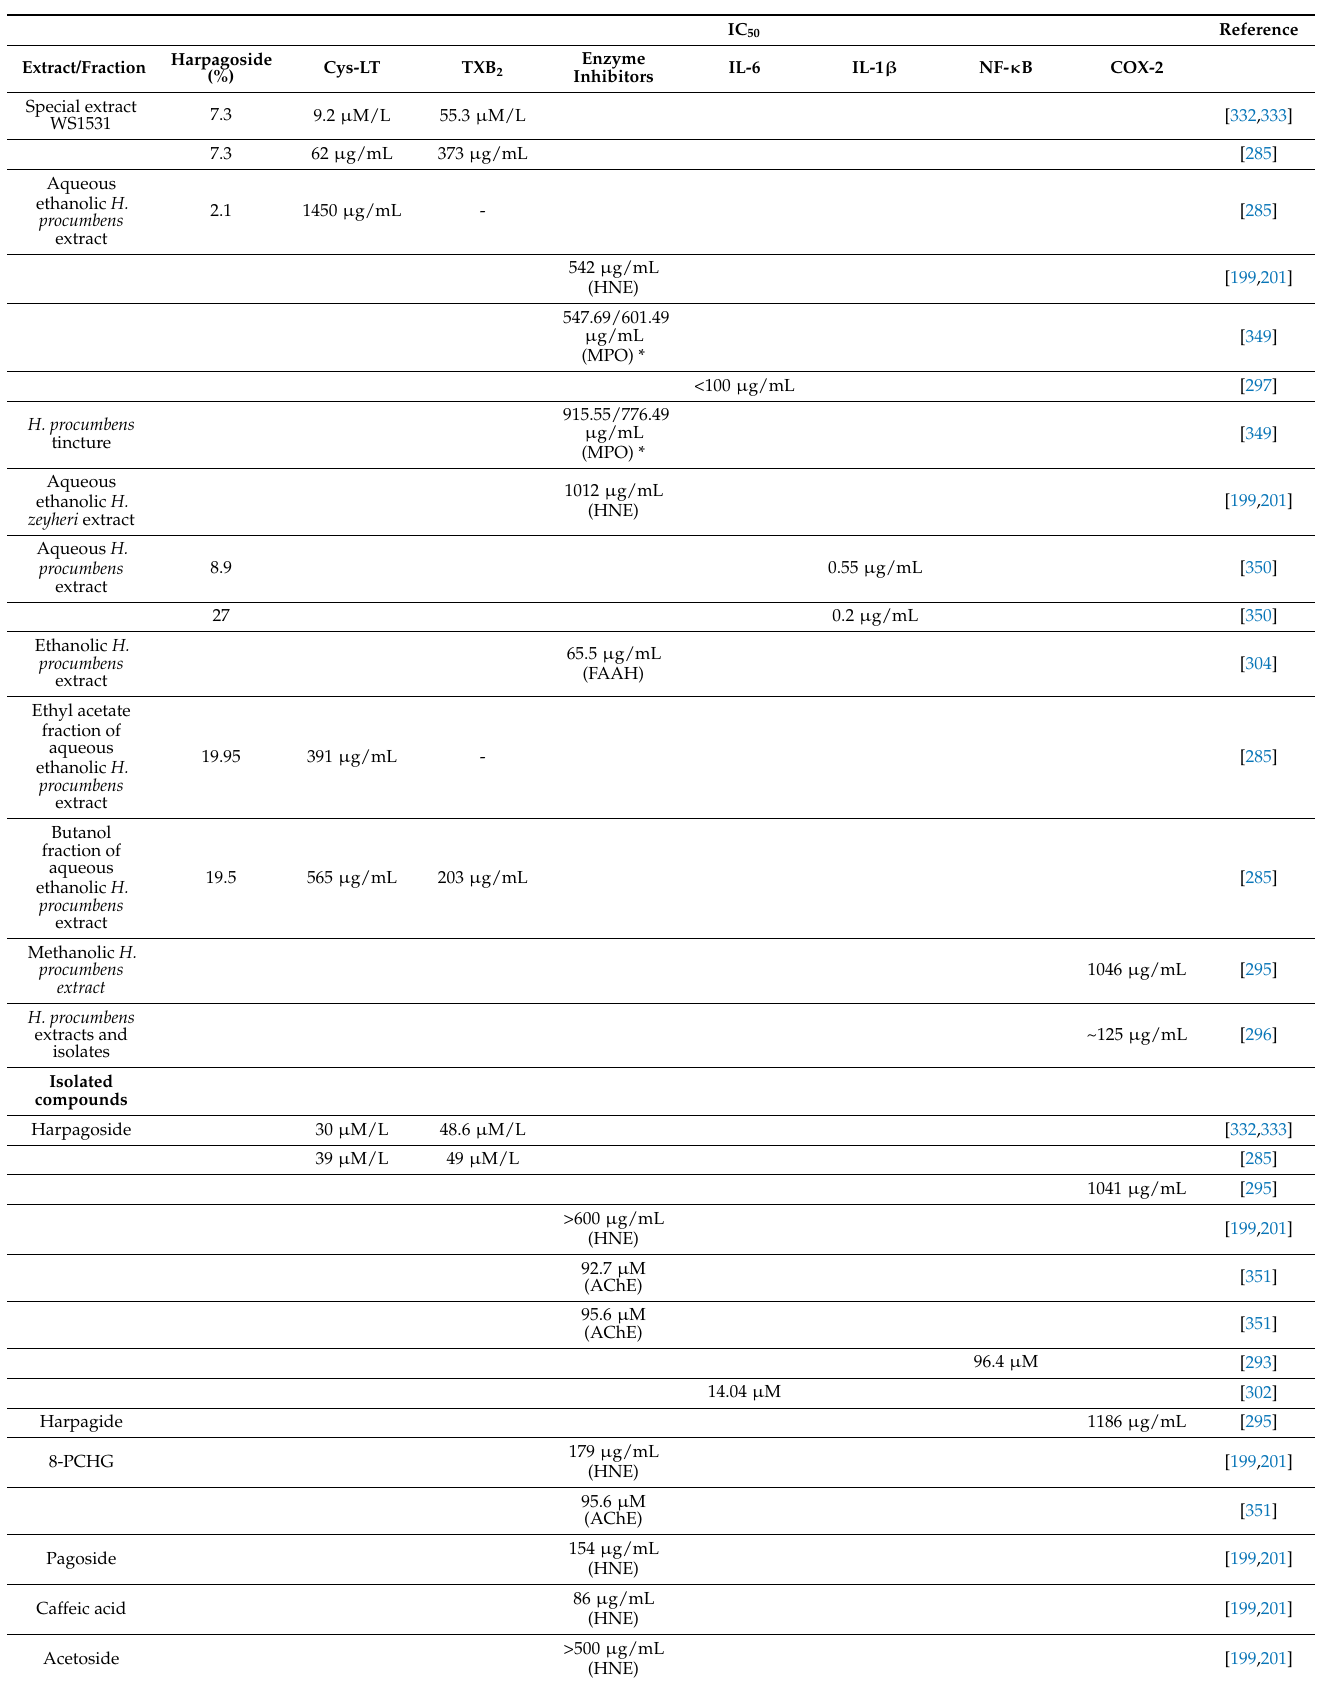
Table 8. Anti-inflammatory targets of Harpagophytum preparations and